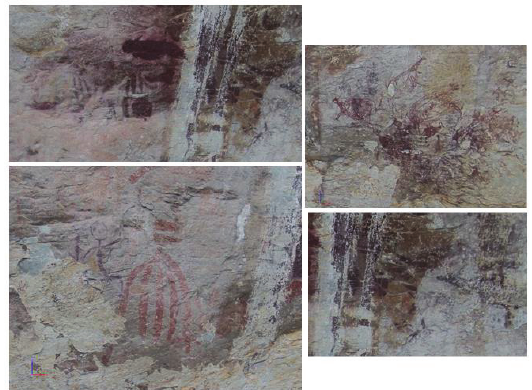
Figure 3: Visualization of the output gained from the